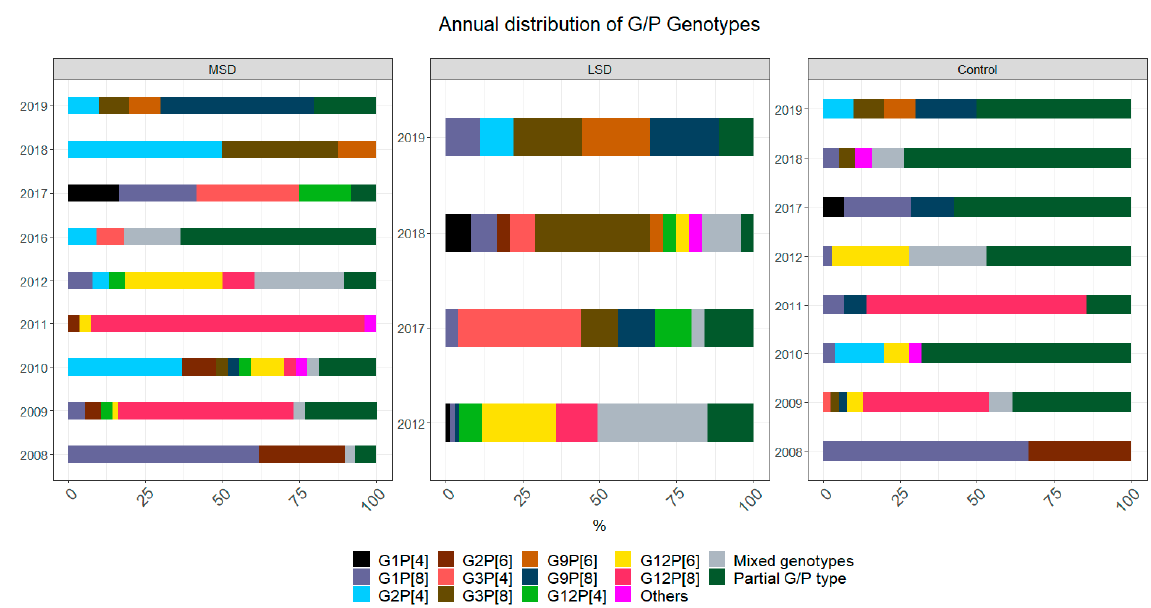
Figure 1. Temporal distribution of rotavirus genotype combinations found in cases and controls in children <5 years of age, in Manhiça (Maragra, Manhiça District Hospital, Taninga, Ilha Josina, Nwamatibjana, Malavele and Xinavane), Mozambique. Data represent two periods, pre-vaccine introduction, January 2008–November 2012, and post-vaccine introduction, January 2016-December 2019. No data were collected in 2013 and 2014. Colours represent each genotype combination specified, which are presented as the proportion (%) of a specific genotype combination among the total number of tested samples in each year for each group (MSD, LSD and controls). MSD—moderate to severe diarrhoea; LSD—less severe diarrhoea; controls: healthy children from the community.